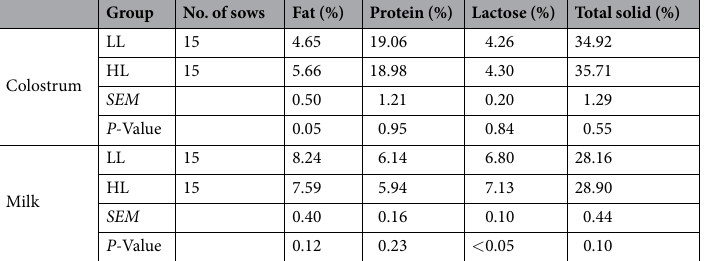
Table 1. Concentrations of fat, protein, lactose, and total solid in colostrum and mature milk of sows. SEM : Standard Error of Mean, n = 15 for each group, LL: low lactation performance group, HL: high lactation performance